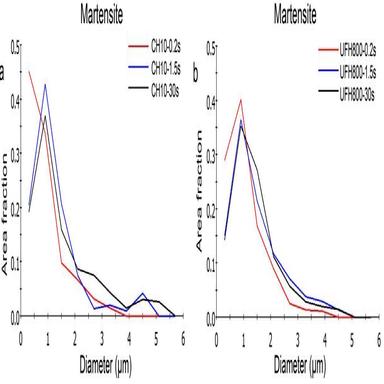
Martensite ECD vs area fraction for CH (a) and UFH (b) for different soaking times: 0.2 s, 1.5 s and 30 s.